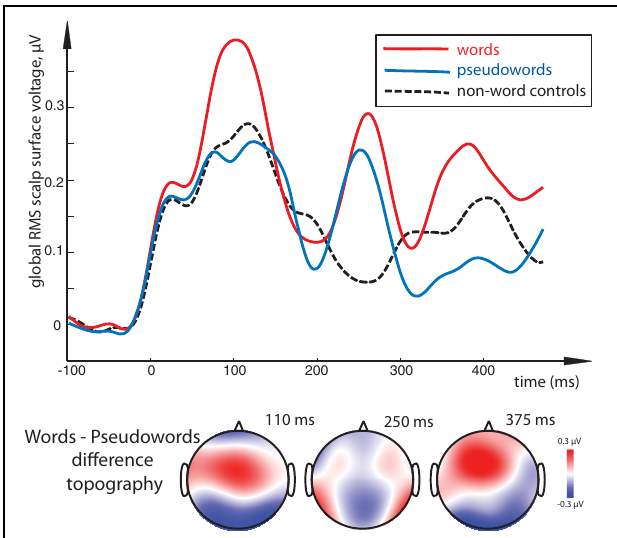
FIGURE 3 | Lexical familiarity effect: global RMS of responses to word, pseudoword and control non-word stimuli (top) and surface voltage topographic maps for the key word-pseudoword lexicality contrast (bottom). Lexical familiarity effect (an increased activation for unattended meaningful words as opposed to matched meaningless stimuli) is visible across the three main peaks; it was most significant in the 100–120ms interval. Remarkably, although words show significant differences from both pseudoword and non-word stimuli, the latter two could not be distinguished statistically. Timecourse of activity elicited by the orthographic stimuli is shown after it has been subtracted by that in the sensory baseline control condition.